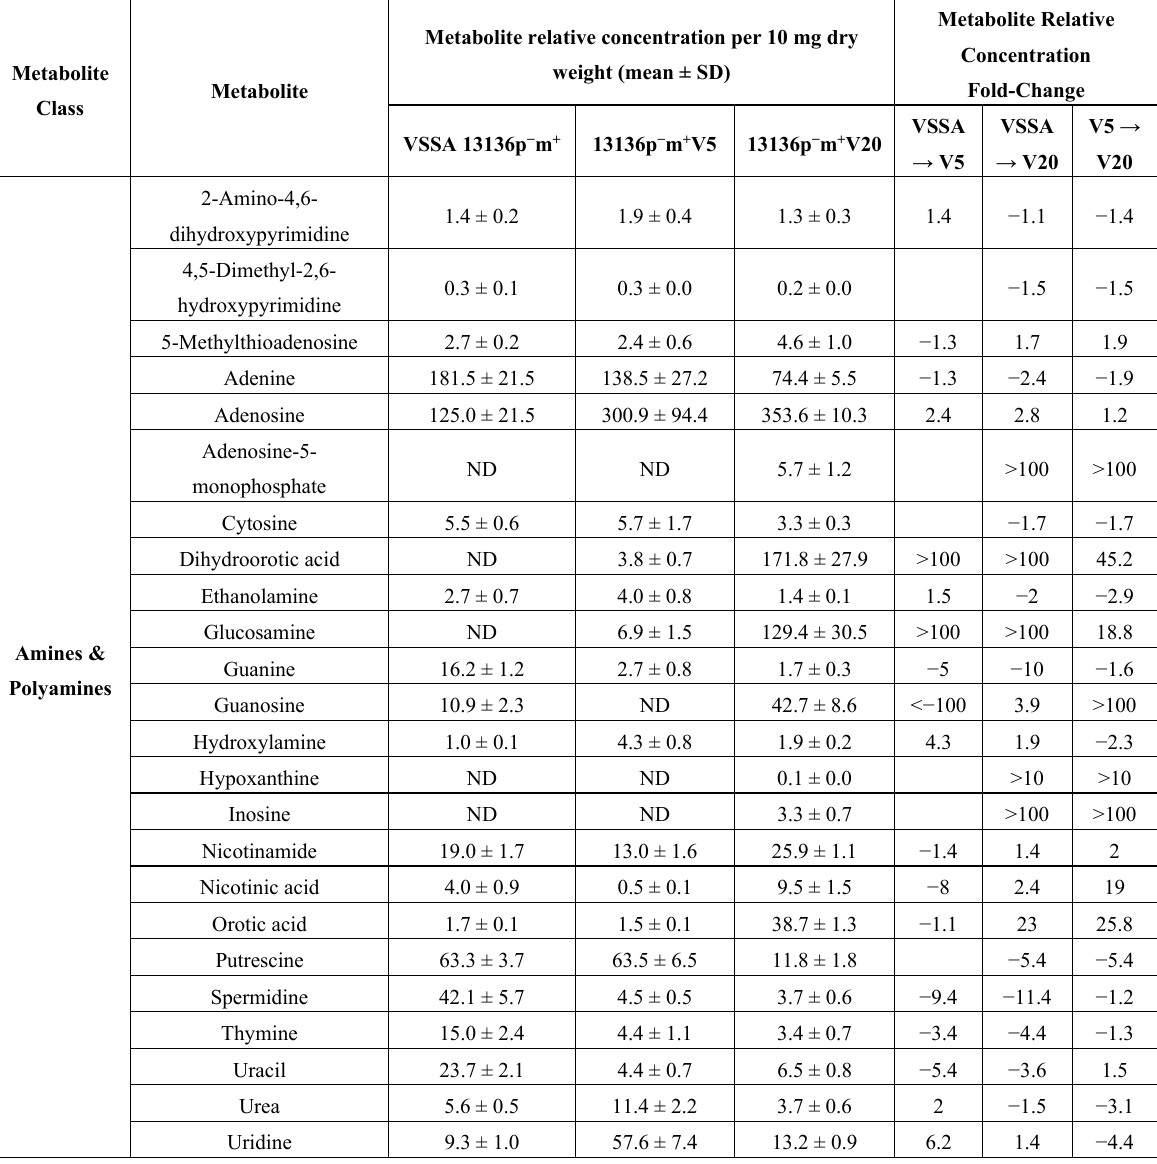
Table 3. The 98 metabolites identified by metabolomic analyses, relative concentrations, and fold-change differences between strains. Empty cells: no changes (one-fold changes); ND: Not Detected, with values of 0.01 used for < and > fold-change estimates. Metabolites within each class sorted